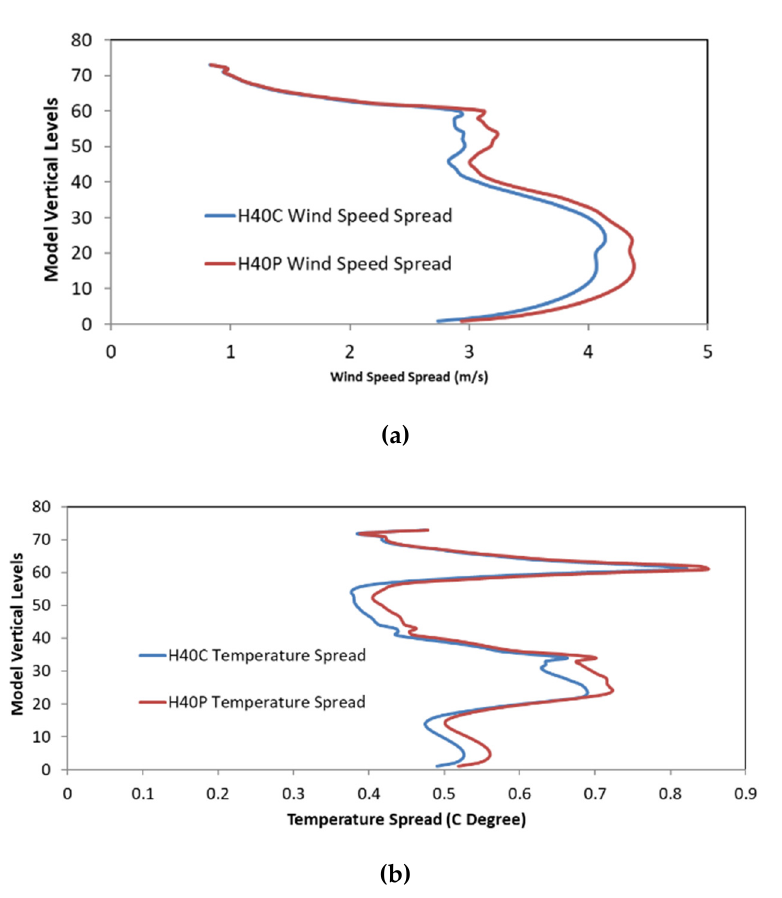
Figure 3. Comparisons of the vertical profiles of the domain-averaged ensemble spread of ( a ) the wind speed, and ( b ) the temperature, averaged over all cycles, between H40C (blue line) and H40P (red line), for Hurricane Hermine, 2016.